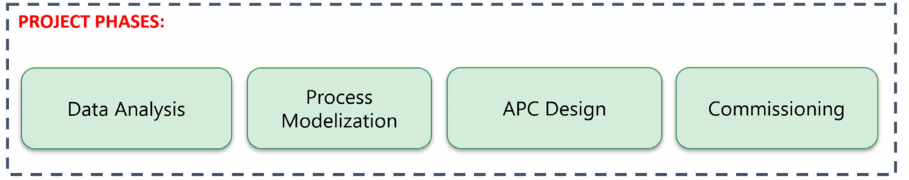
Figure 5. Schematic representation of the project management